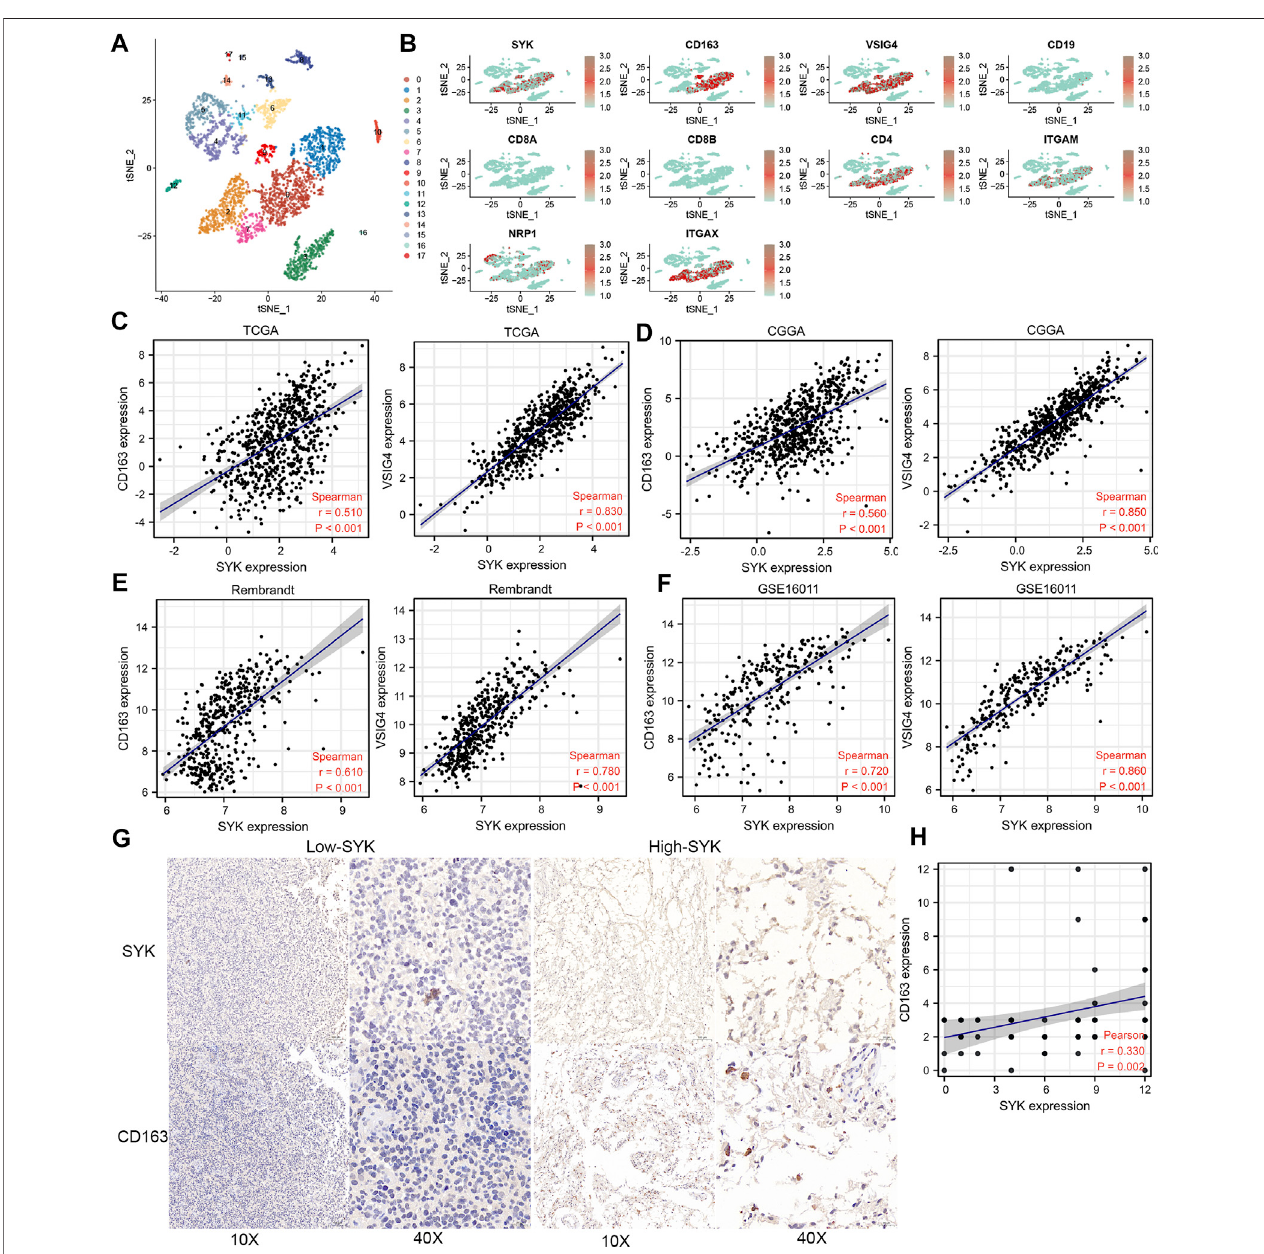
FIGURE7| ExpressionpatternofSYKbysingle-cellsequencinganalysisandtheassociationbetweenSYKexpressionandM2macrophagein fi ltration. (A,B) SYK expression in the different cell types; (B – F) The correlation between SYK expression and CD163 and VSIG4 expression in the four cohorts. (G,H) The correlation between SYK expression and CD163 expression by IHC